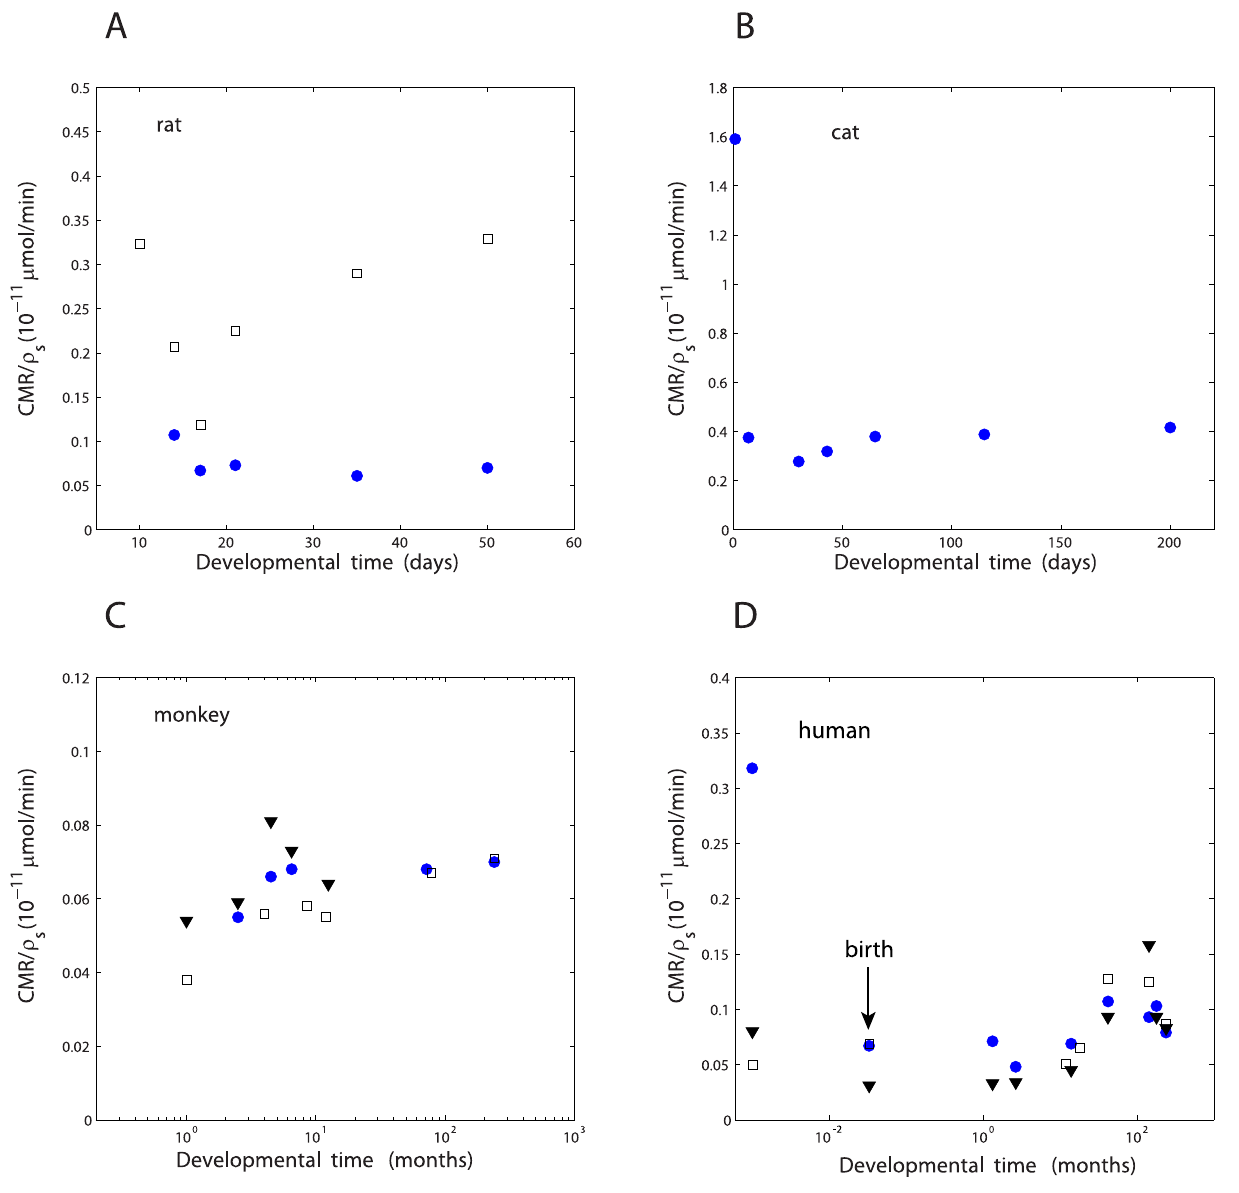
Figure 2. Approximate invariance of glucose cerebral metabolic rate per synapse during development. The linear fits to the data points are given in the brackets below. (A) Rat (circles - parietal cortex: y ~{ 0 : 0006 x z 0 : 092 , R 2 ~ 0 : 259 , p ~ 0 : 381 ; squares - visual cortex: y ~ 0 : 0025 x z 0 : 187 , R 2 ~ 0 : 223 , p ~ 0 : 345 ). (B) Cat visual cortex (with the data point at 1 day: y ~{ 0 : 0023 x z 0 : 684 , R 2 ~ 0 : 118 , p ~ 0 : 451 ; without the data point at 1 day: y ~ 0 : 0005 x z 0 : 322 , R 2 ~ 0 : 438 , p ~ 0 : 152 ). (C) Monkey (circles - frontal cortex: y ~ 0 : 00003 x z 0 : 063 , R 2 ~ 0 : 279 , p ~ 0 : 363 ; squares - visual cortex: y ~ 0 : 00009 x z 0 : 052 , R 2 ~ 0 : 527 , p ~ 0 : 102 ; triangles - sensorimotor cortex: y ~ 0 : 0007 x z 0 : 063 , R 2 ~ 0 : 075 , p ~ 0 : 656 ). (D) Human (circles - frontal cortex: y ~{ 0 : 0001 x z 0 : 116 , R 2 ~ 0 : 025 , p ~ 0 : 684 ; squares - visual cortex: y ~ 0 : 0002 x z 0 : 071 , R 2 ~ 0 : 223 , p ~ 0 : 282 ; triangles - temporal cortex: y ~ 0 : 0003 x z 0 : 053 , R 2 ~ 0 : 375 , p ~ 0 : 079 ). In the above fits y refers to CMR/ r s (in 10 { 11 m mol/min) and x to the developmental time (either in days for rat and cat or in months for monkey and human). Note that for all fits the linear coefficient is close to